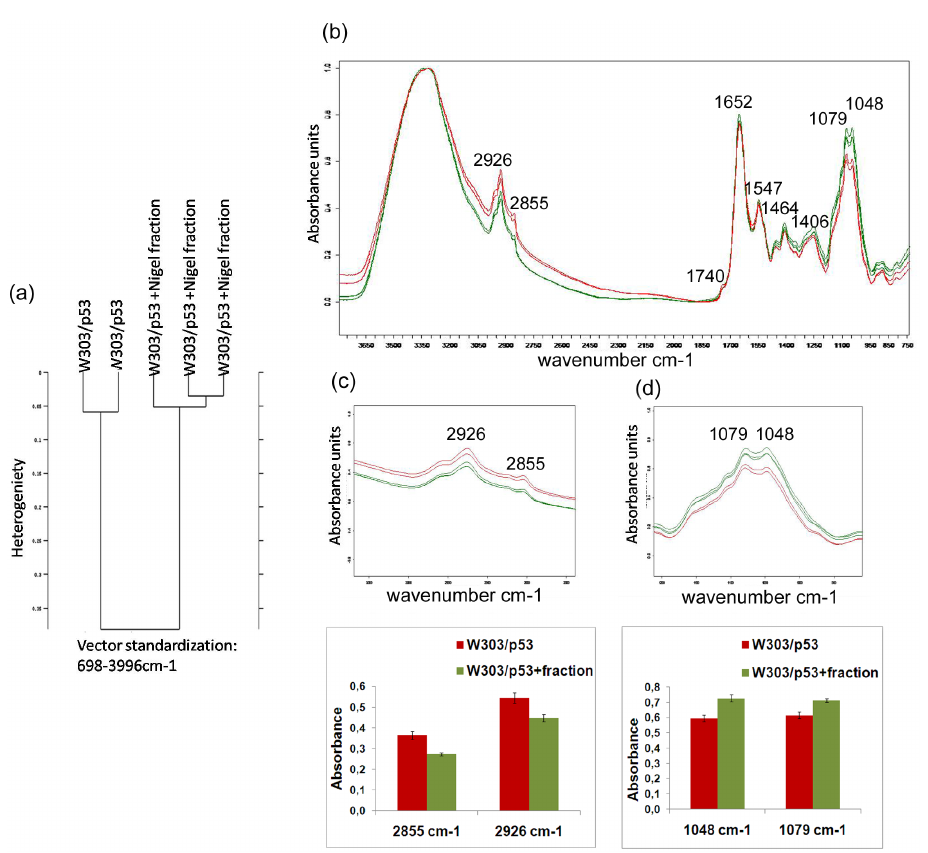
Fig 5. FTIR spectroscopy analysis of the whole recombinant yeast clones W303/p53 grown in MMGAL in absence and presenceof purified Nigel extract. (a) Dendrogramrepresentingthe cluster analysisof W303/p53 grown in MMGAL in absenceand in presenceof nigel fraction and W303/p53. (b) FTIR spectra of W303/p53 (red line) and W303/p53 (green line) grown on MMGAL in absenceand presenceof nigel fraction, (c) spectral intensity band changesin 3000–2820cm − 1 regionshowingmembranechangesand (d) spectral intensity band changesin 1187-945cm-1 regionshowingDNA changes.The values are means of three independent